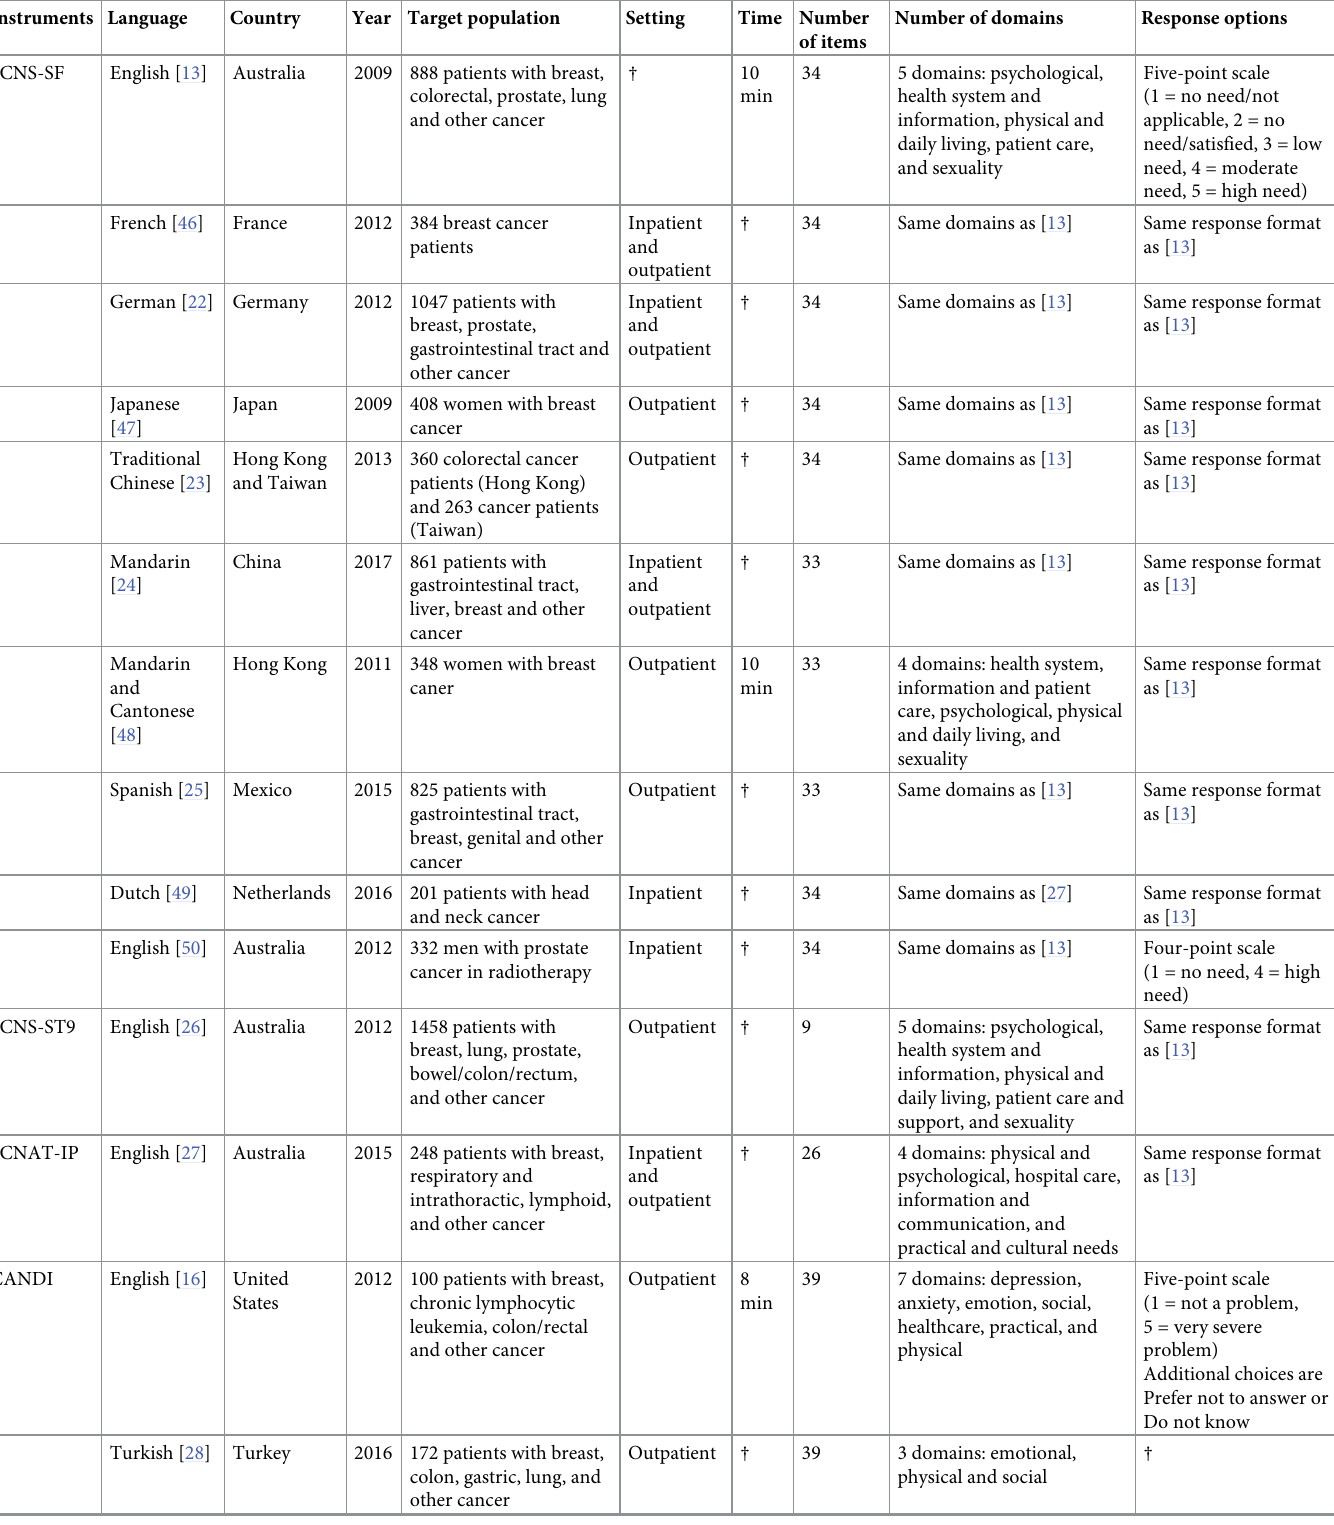
Table 1. Characteristics of the study populations and the needs assessment tools in cancer patients. Instruments